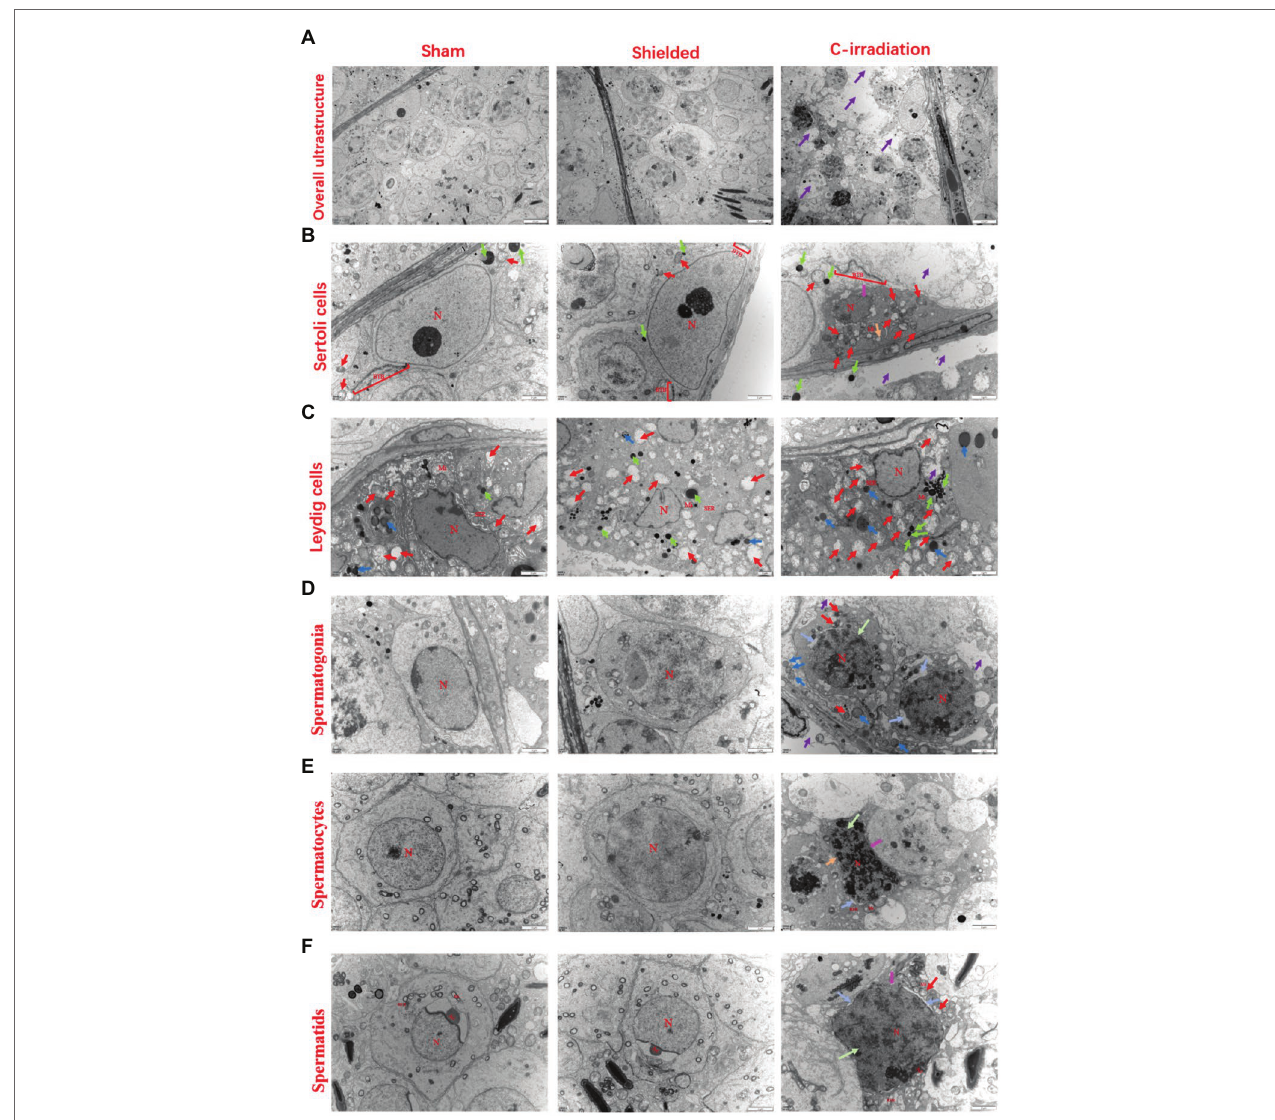
FIGURE 2 | The abscopal effects of C-irradiation damage the testicular ultrastructure. (A) Overall ultrastructure of seminiferous tubules. Bar = 10 μ m. (B – F) Ultrastructure of Sertoli cells, Leydig cells, spermatogonia, spermatocytes and spermatids. Bar = 2 μ m, n = 2 for each group. N, nucleus; Mi, mitochondrion; RER, rough endoplasmic reticulum; BTB, blood-testis barrier; and Ac, acrosome. Lipid droplets , mitochondrial swelling , secondary lysosomes , RER dilatation , loss of intracytoplasmic solutes , widened perinuclear gap and suspected apoptosis